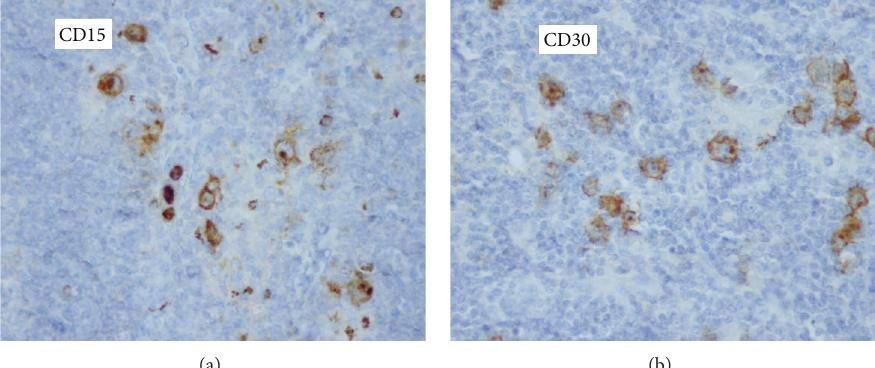
Figure 3: Immunohistochemical analysis showing positive staining of the Reed-Sternberg cells for (a) CD15 and (b) CD30.